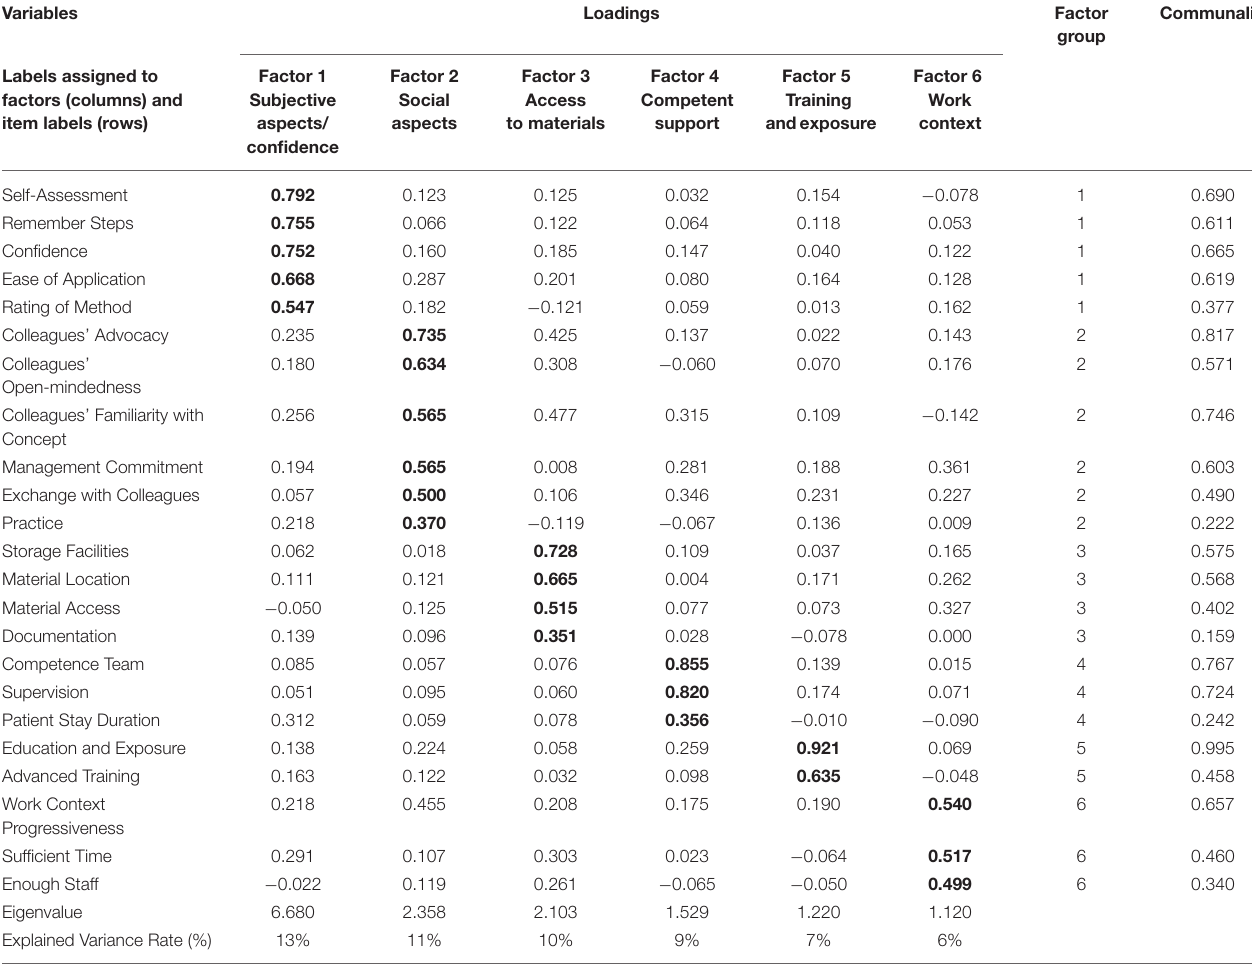
TABLE 3 | Results of the exploratory factor analysis including factor loadings and communalities. Variables